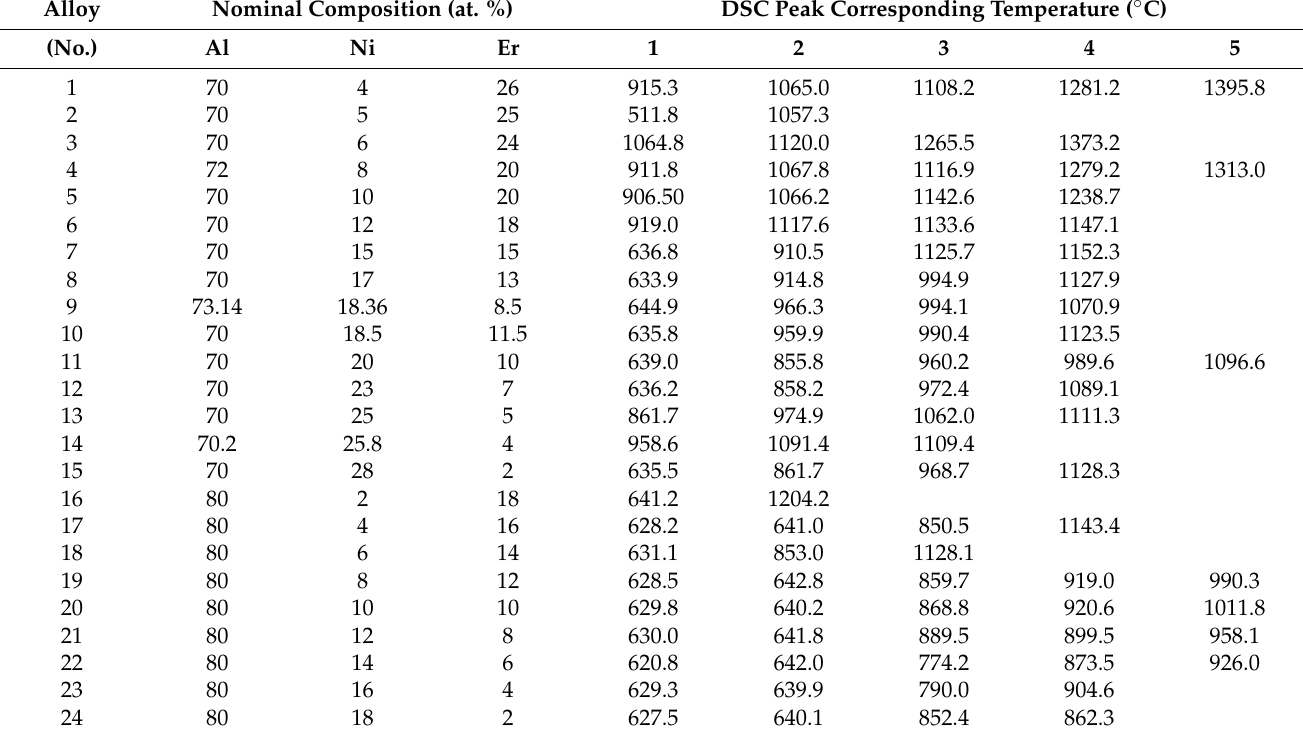
Table 4. Temperatures corresponding to thermal events recorded with